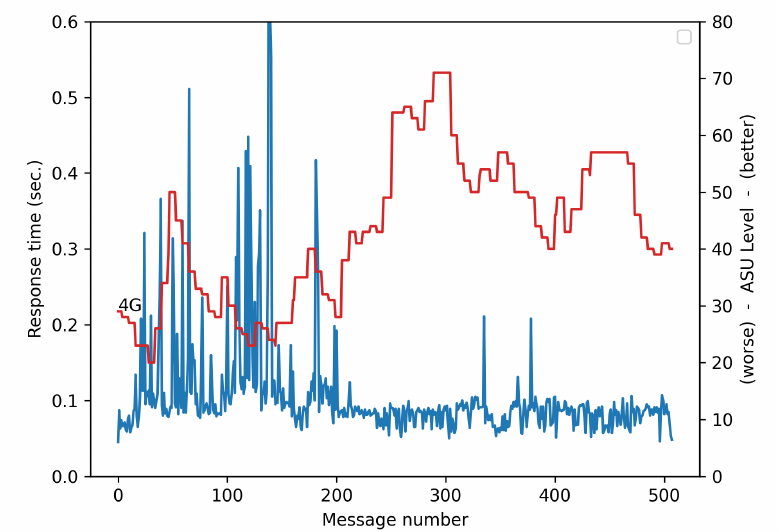
Figure 9. A trace of a trip showing the evolution of signal power (expressed in ASU) and re- sponse time.